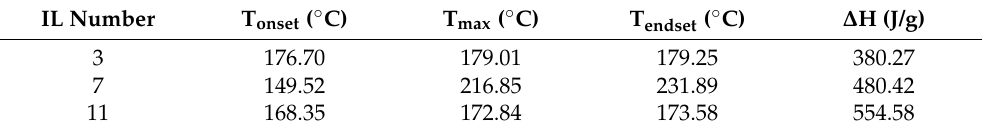
Table 5. Curing properties of triflate-based ionic liquids.